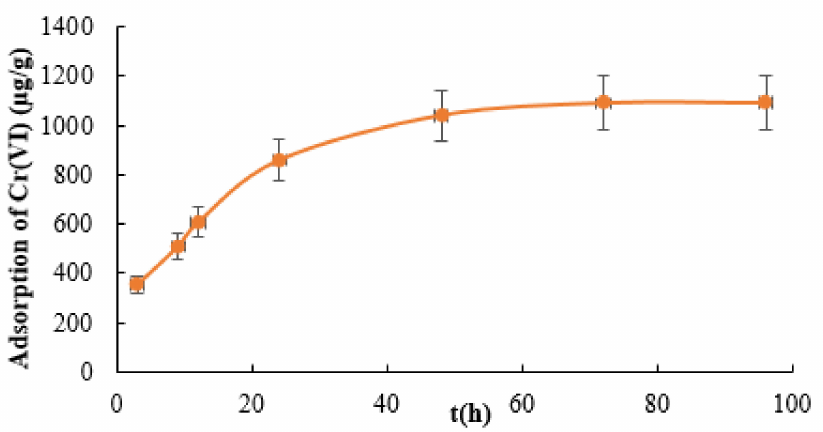
Figure 5. E ff ect of the contact time on the adsorption of Cr(VI) on the SDS-modified chitosan